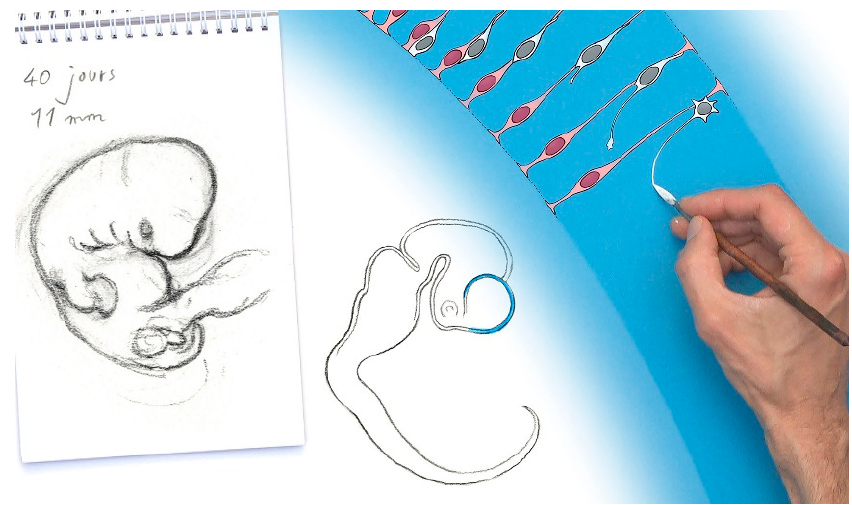
Figure 5. Sketch and color rendering for video, “Birth of the brain,” documents the process of working from traditional media, pencil and brush, to digital animation. Image courtesy Renaud Chabrier.